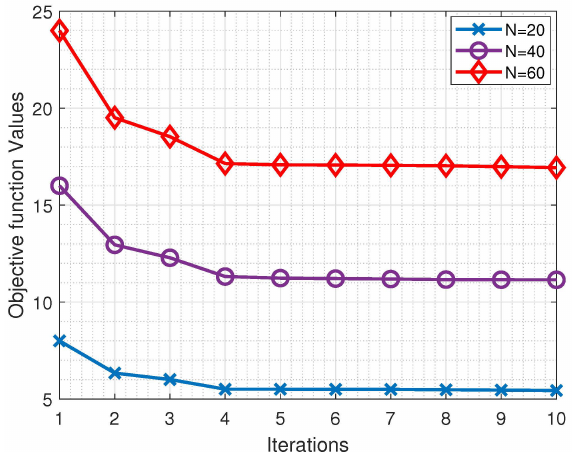
Figure 3. Algorithm convergence graph.